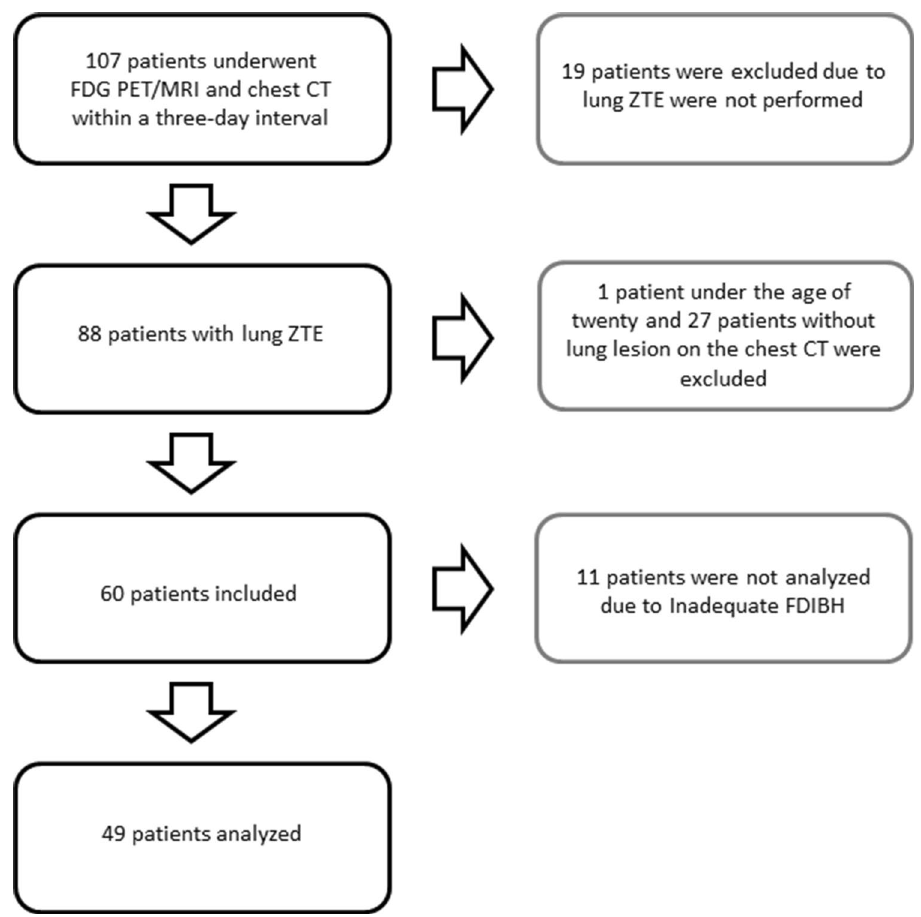
Figure 1. Flowchart of patient inclusion (black) and exclusion